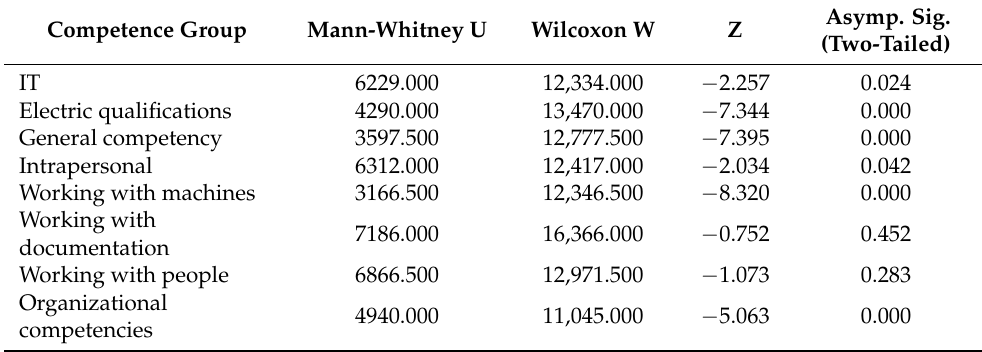
Table 13. U Mann-Whitney